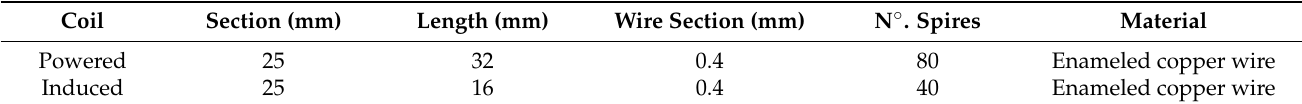
Table 1. Description of coils composing the sensor.